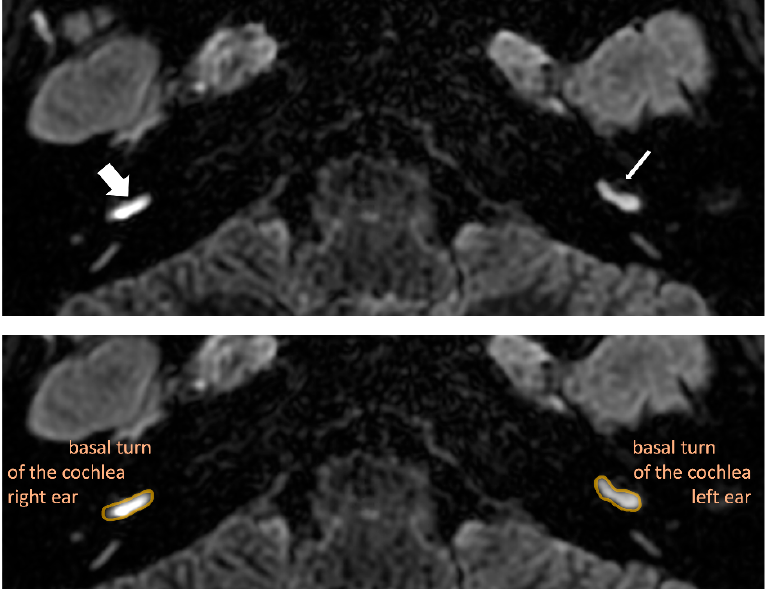
Figure 3. Delayed post-contrast 3D-FLAIR axial image of both ears at the level of the basal turn of the cochlea. In the top image, there is more robust enhancement of the basal cochlear turn on the affected right side (thick arrow), compared with normal perilymphatic enhancement on the left side (thin arrow). The bottom image is the same as the top one but in the form of a companion scan with some line art applied to define specific anatomical structures for easier identification of observed pathologies.